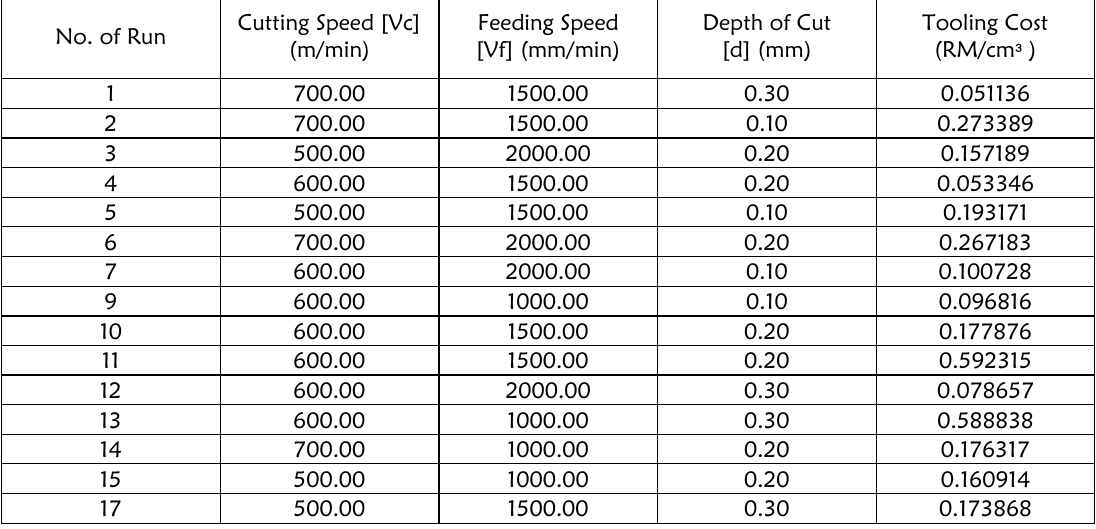
Table 2: Result of